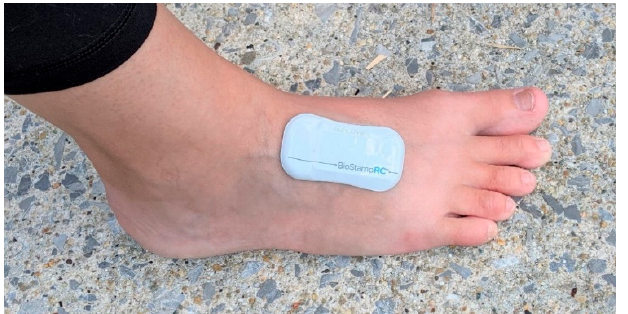
Figure 1. The soft, conformable BiostampRC sensor attached directly to the dorsal surface of the foot before the sock and shoes were put on.